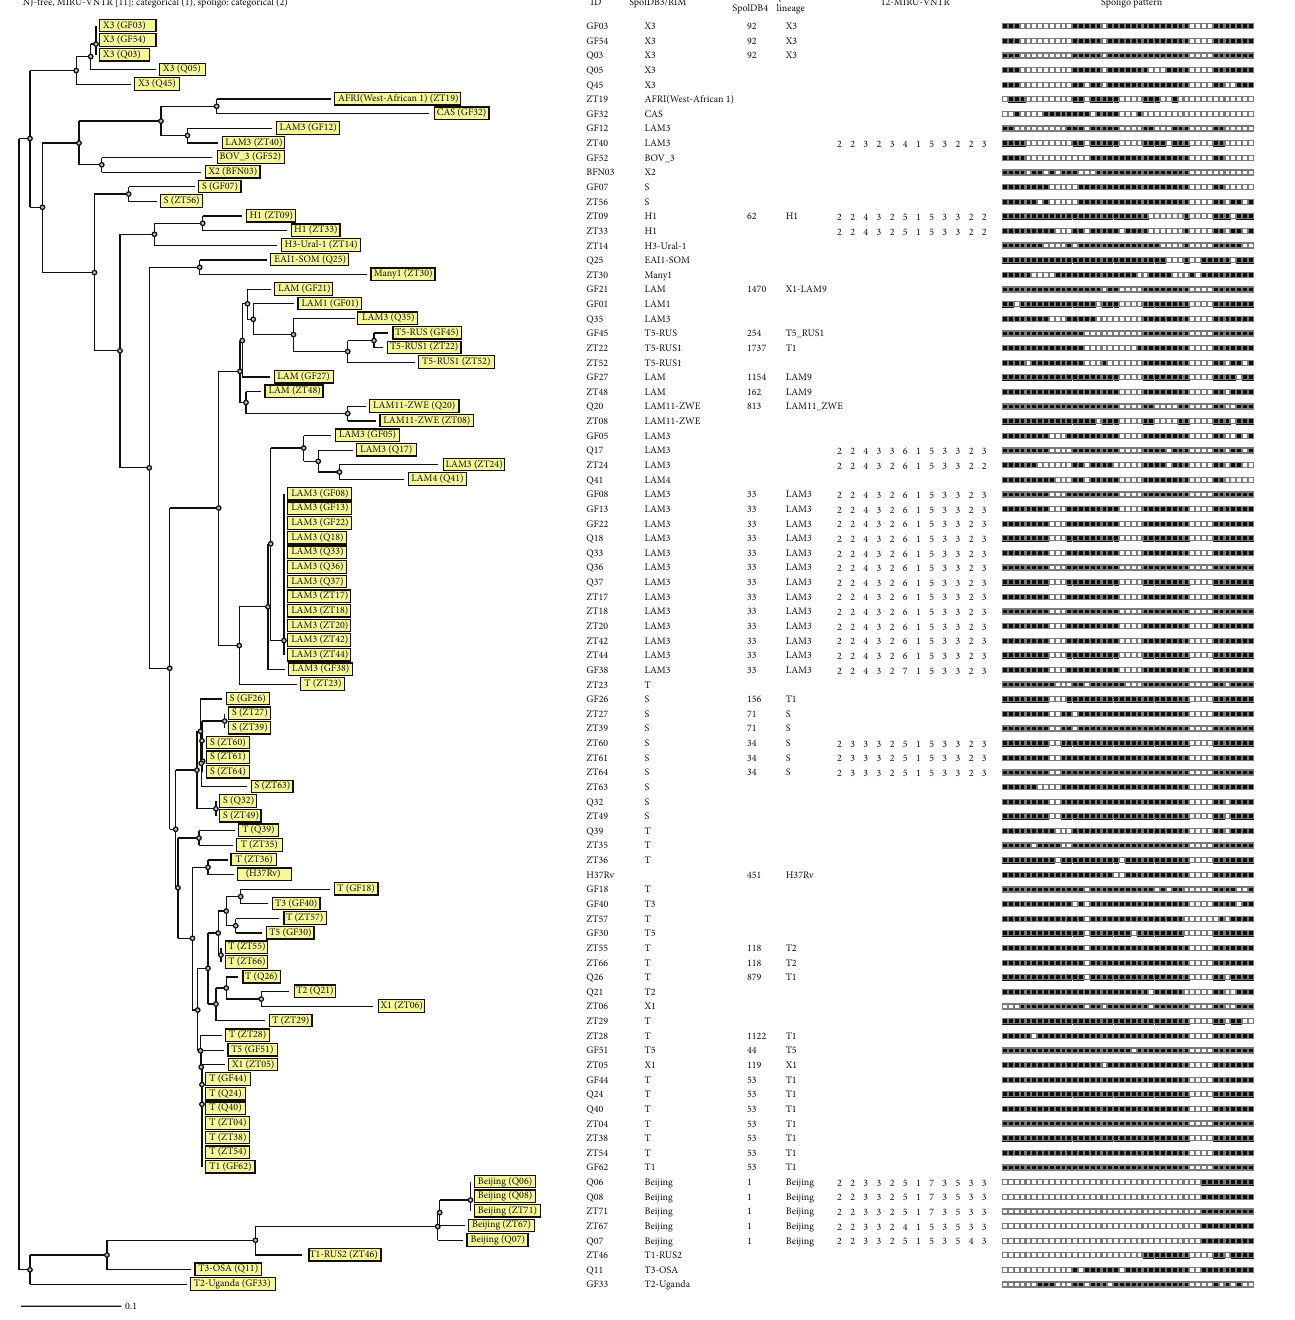
Figure 1: MIRU-VNTRplus cluster analysis of 86 isolates and an H37Rv control strain with spoligotyping and MIRU-VNTR profiles investigated in this study. The phylogenetic tree was rooted from M. canettii arranged according to similarities of spoligotypes using a Jaccard distance coefficient of 2 and for MIRU-VNTR types using a categorical value of 1. Included in the figure is, from left, phylogenetic tree drawn using neighbour-joining clustering algorithms (NJ), strain ID, most probable lineage determined with the TB-lineage database (SPOTCLUST according to the SpolDB3, combined with the Randomly Initialised Model (RIM)), SIT number and lineage according to SpolDB4 (MIRU- VNTRplus DB version), MIRU-VNTR profiles, and spoligotypes (1 to